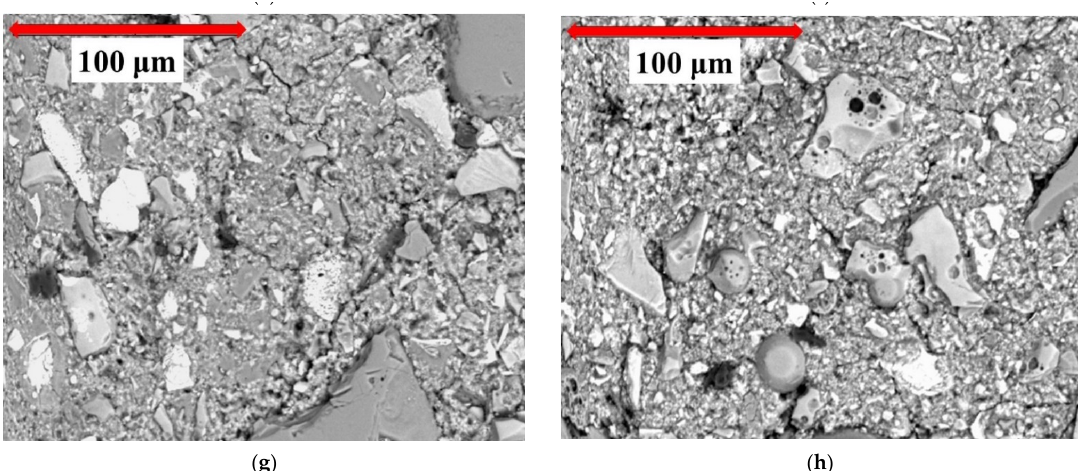
Figure 15. Back-scattered electron (BSE) micrographs of mortars either at 28 days or 90 days: ( a ) CEM I ( α ) 28 days; ( b ) CEM I ( α ) 90 days; ( c ) CEM II/A-V- β 28 days; ( d ) CEM II/A-V- β 90 days; ( e )